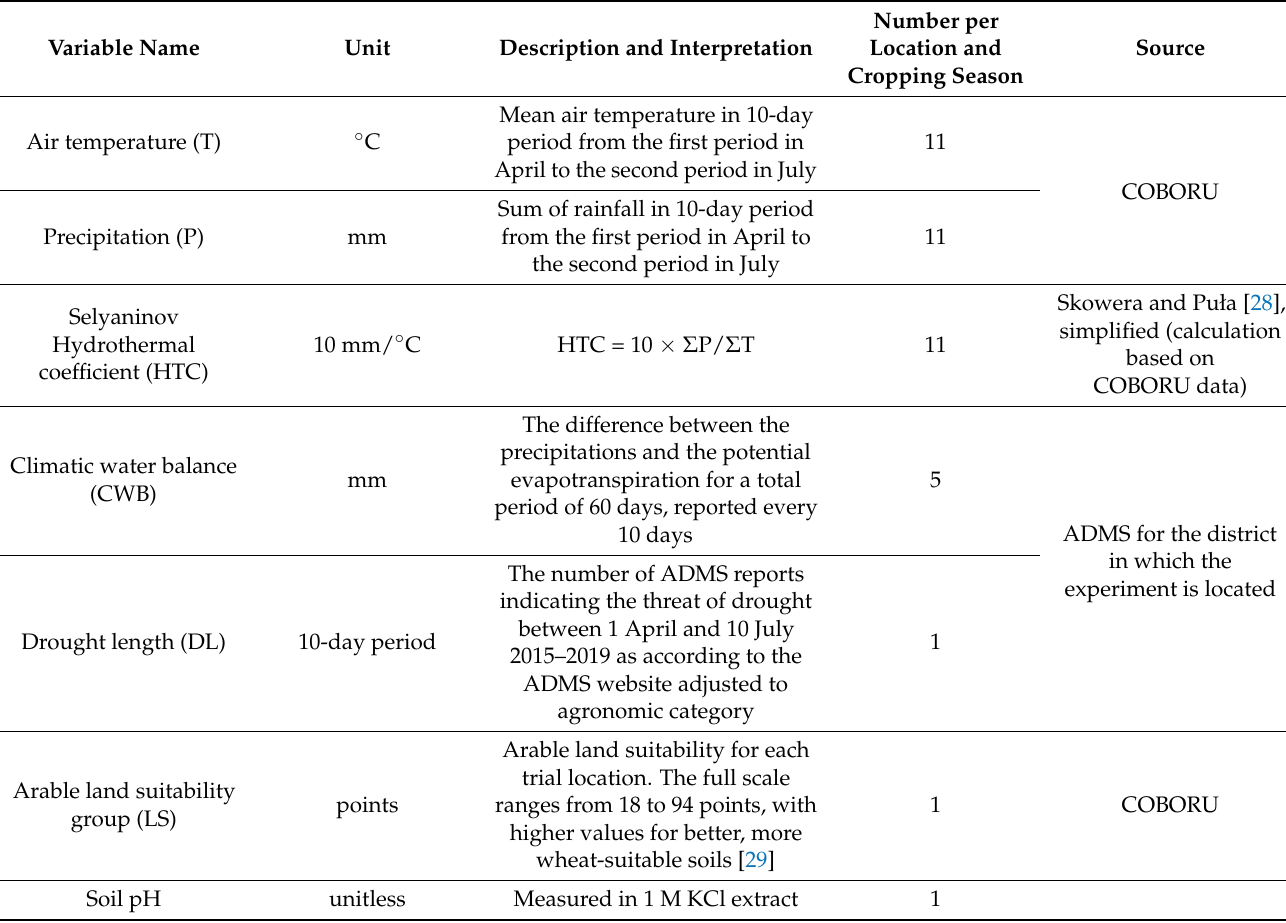
Table 1. Description of the environmental traits used in the statistical analysis (Iwa´nska et al. [11],